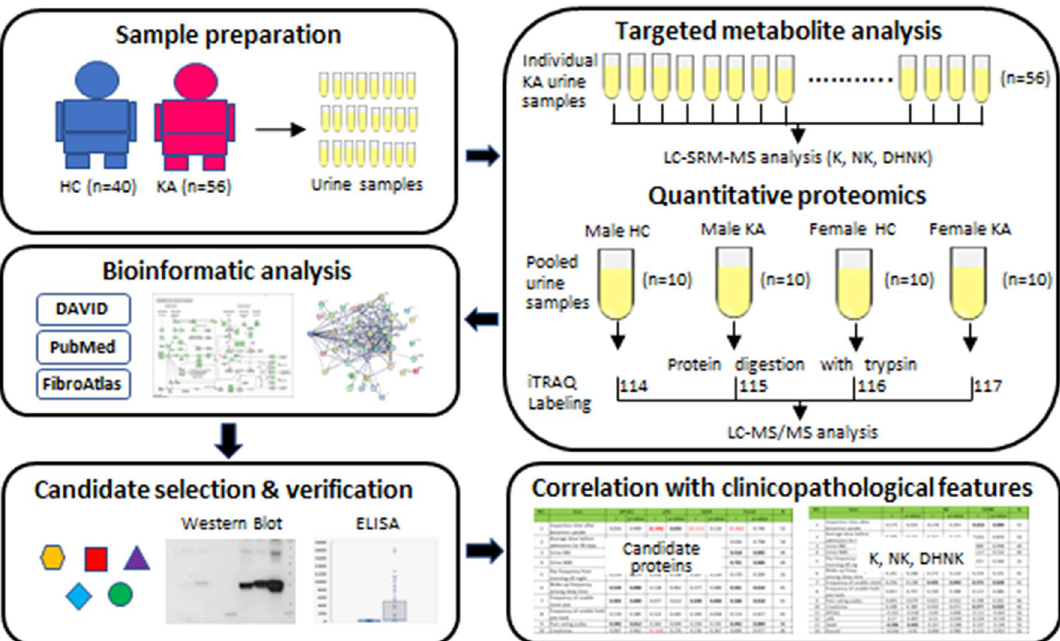
Figure 1. Workflow for exploring urine proteome alteration in KA and the association between urine protein levels, contents of ketamine and its metabolites and clinicopathlogical features of KA. Please refer to the text for